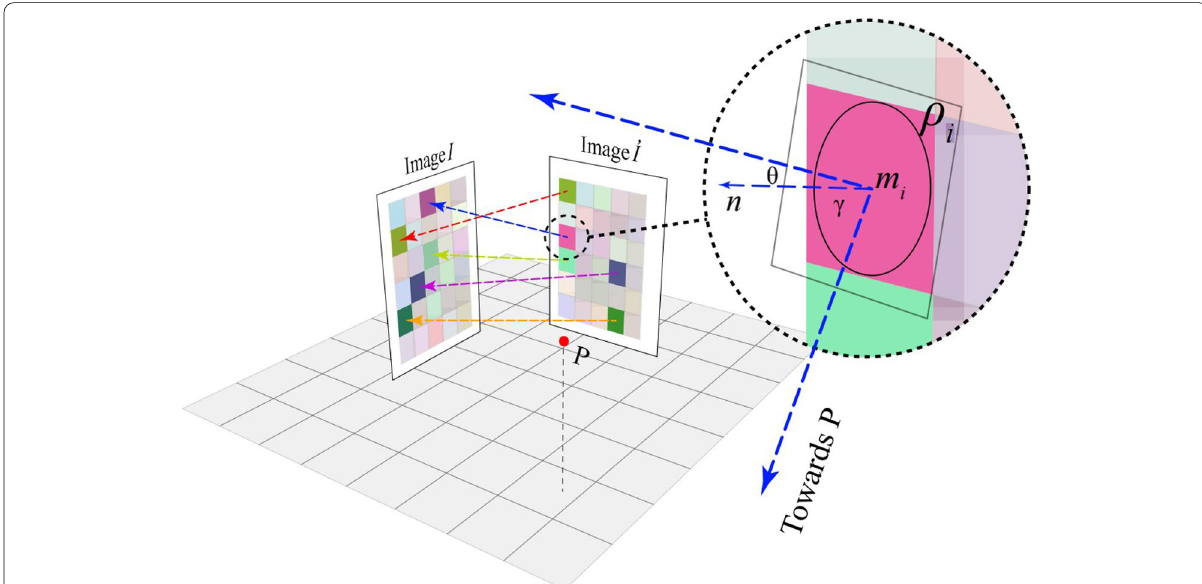
Fig. 11 The device made by Hosseini et al. [22]. consists of one image I served as a palette and a set of mirror arrays to display I ´ . When the user looks at the mirror at the viewpoint P , the mirror reflects colors from I to form I